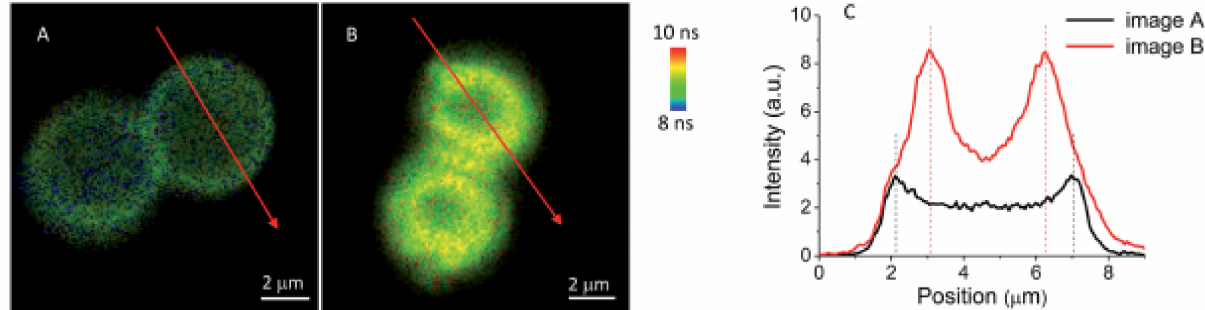
Figure 4. Microcapsules with the sequence (PAH/PSS) 5 -(PAH-TCPP)-PSS in water at: ( A ) pH = 5.6; and ( B ) pH = 7.0. ( C ) Intensity profiles of the red arrows in images ( A ) and ( B ). Reproduced from [89] with permission from The Royal Society of Chemistry.